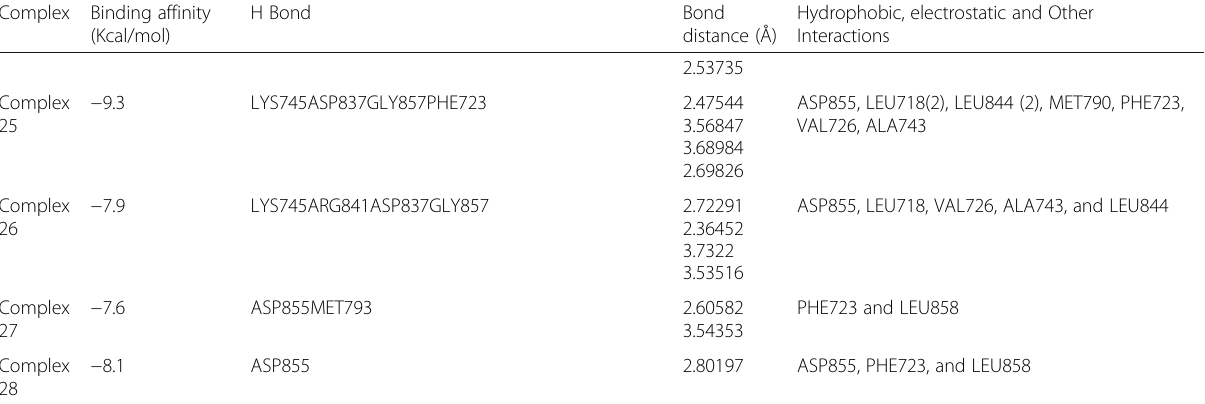
Table 2 The interactions of the molecules under investigation in the active site of EGFR receptor (Continued)